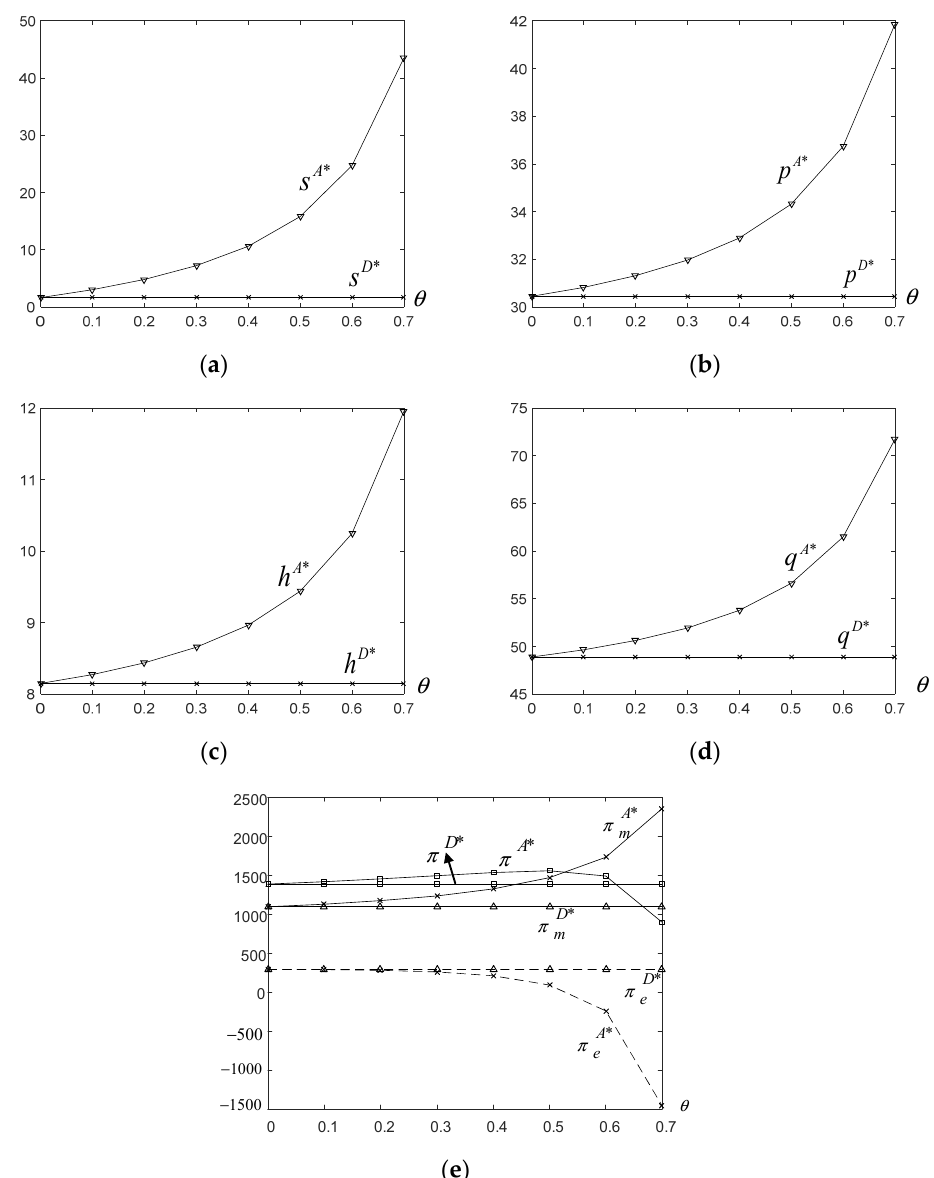
Figure 2. Changing graphs of the decision variables in the basic models with the altruistic preference coefficient: ( a ) the changes of 𝑠 over 𝜃 ; ( b ) the change of 𝑝 over 𝜃 ; ( c ) the changes of ℎ over 𝜃 ; ( d ) the changes of 𝑞 over 𝜃 ; ( e ) the changes of profits over 𝜃 .